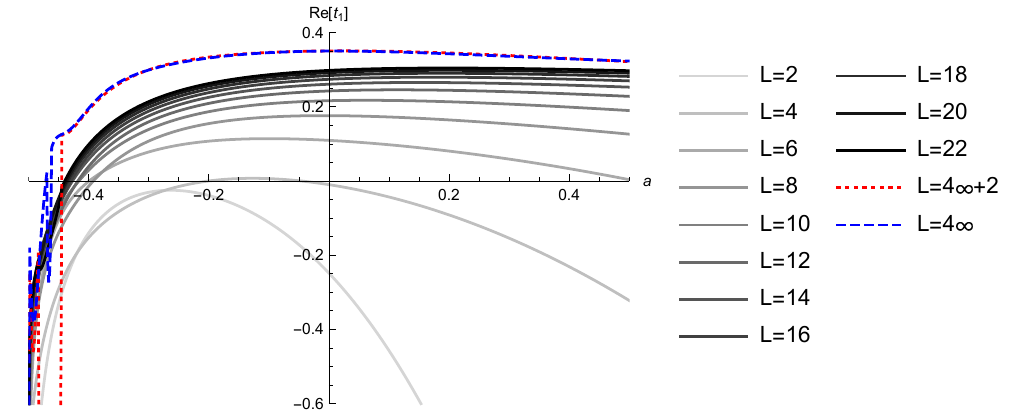
Figure 17 . Plots of the real part of the coefficient of the lowest level state c 1 | 0 i for the “double brane” solution Φ D at the truncation level L . The dotted and dashed lines are extrapolations to a L = 4 k + 2 ( k → ∞ ) and L = 4 k ( k → ∞ ), respectively. The horizontal axis denotes the values of the parameter a .